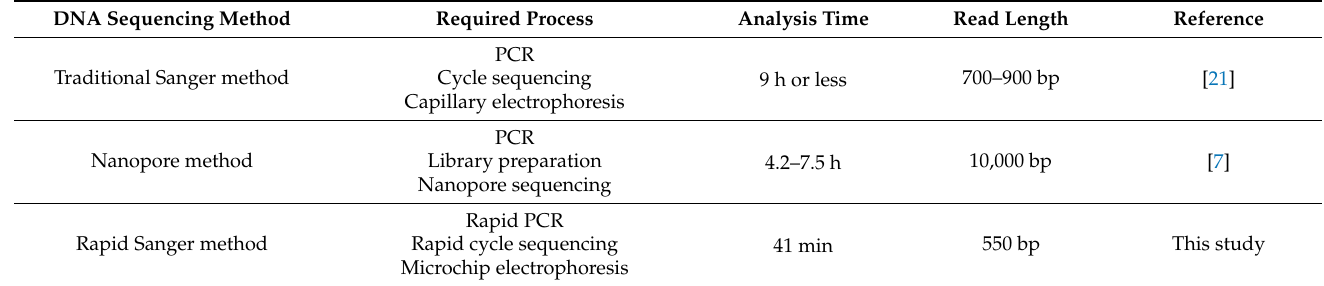
Table 1. The comparison of bacterial identification by different sequencing